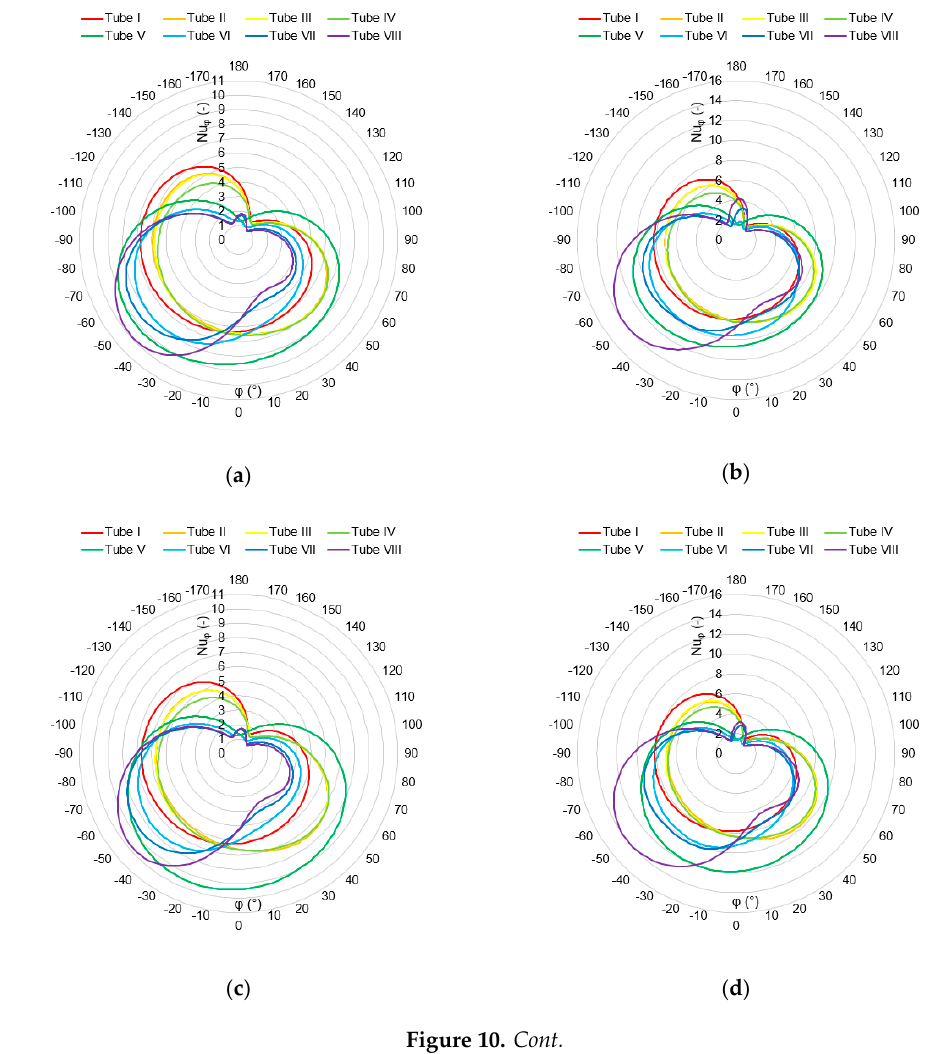
Figure 9. The comparison of the local Nusselt numbers Nu φ of the single cylinder with the bottom tube of the tube arrays at Ra = 10 3 and Ra = 10 4 .